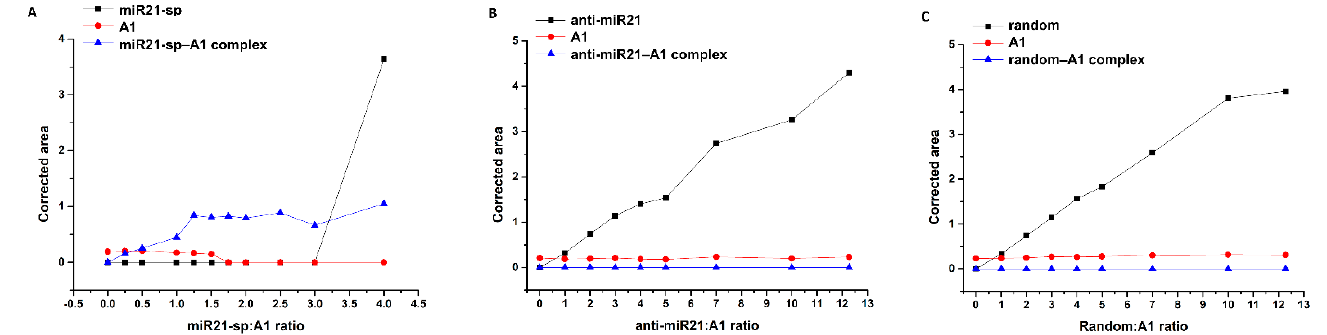
Figure 6. Assessment of miR21 analogues binding selectivity toward A1, using a fixed concentration of A1 (2.22 µM) and increasing concentration of the tested oligonucleotides: ( A ) miR21-sp ( B ) anti- miR21 ( C ) random (obs: migration time corrected peak areas normalized against the corrected peak area of OG were used).